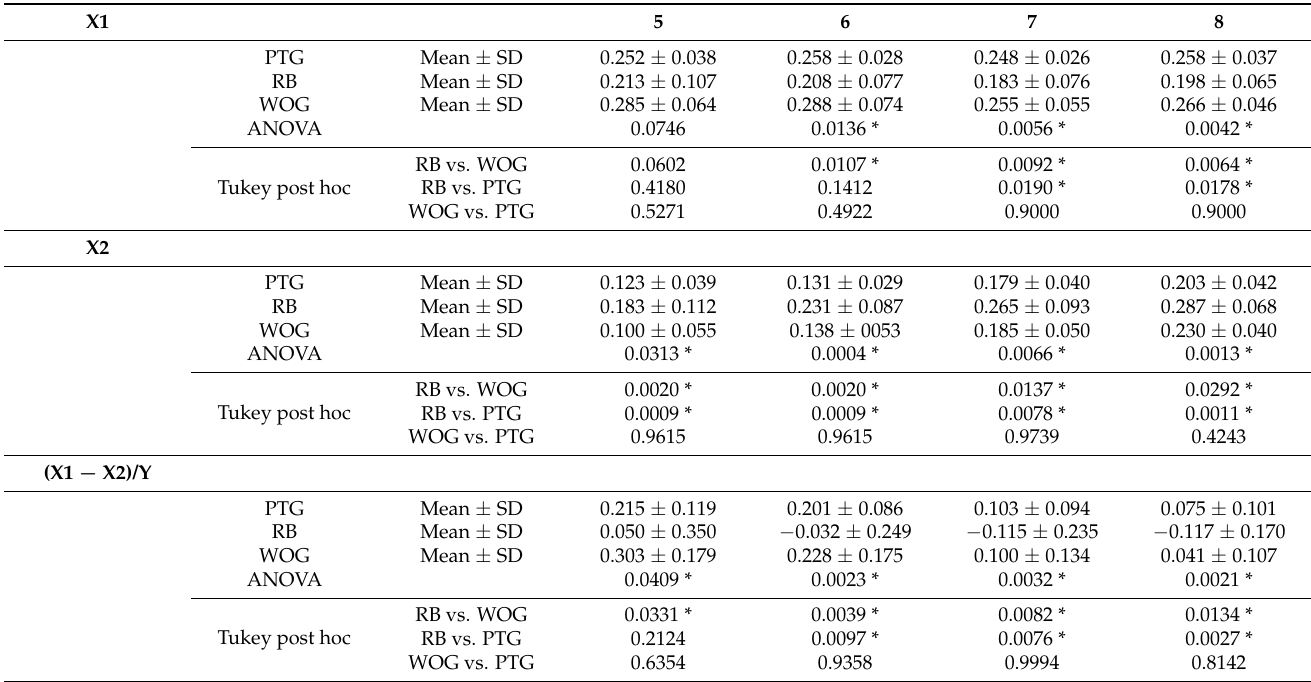
Table 2. X1, X2, and X1 − X2/Y mean value, standard deviation SD and ANOVA with Tukey’s post hoc test for the middle third.